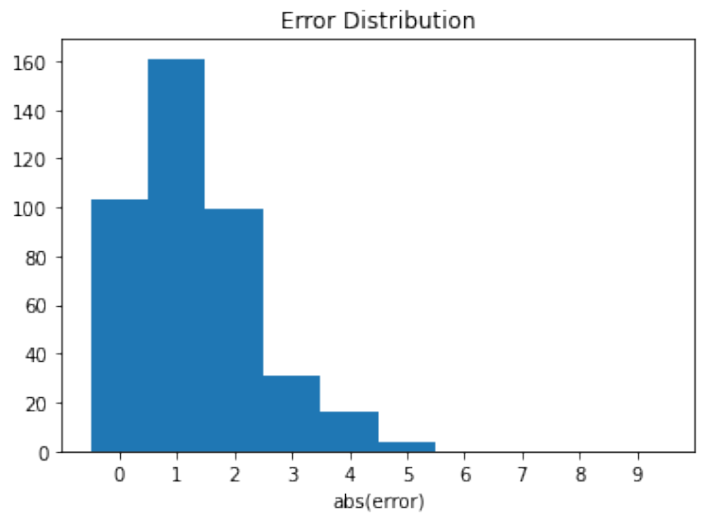
Figure 5. Error distribution of Culex Italy case using both EO and entomological